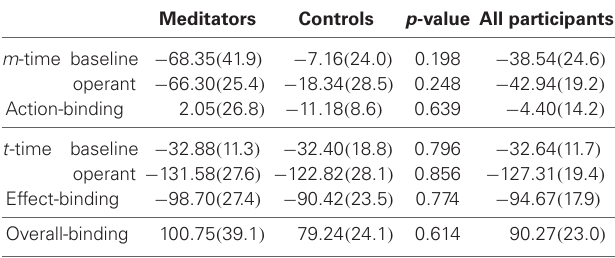
Table 1 | Means of reported times and temporal binding effects during intentional binding tasks